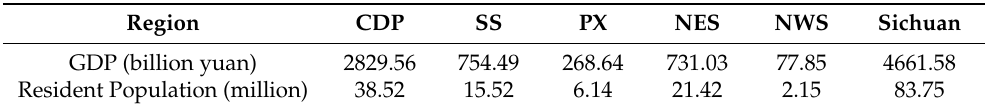
Table 9. Statistics of GDP and resident population of Sichuan and its five economic regions (data from 2019). Region CDP SS PX NES NWS Sichuan GDP (billion yuan) 2829.56 754.49 268.64 731.03 77.85 4661.58 Resident Population (million) 38.52